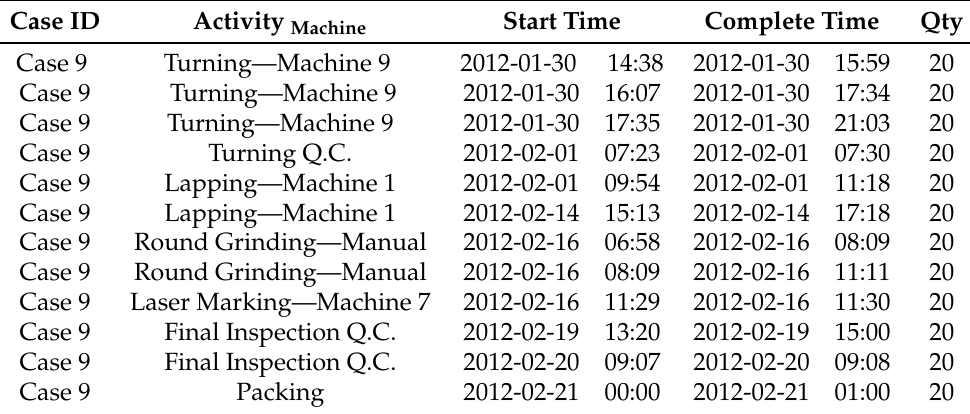
Table 4. Metal processing event log of Case 9.